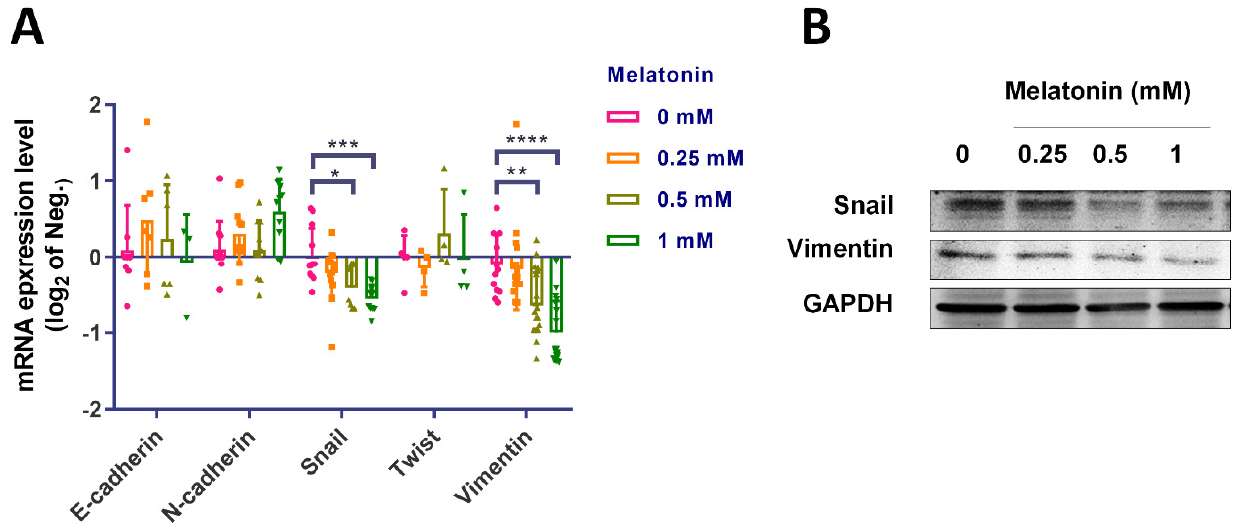
Figure 3. Melatonin inhibited EMT markers in bladder cancer cells. T24 bladder cancer cells, treated with various concentrations of melatonin (0–1 mM) for 24 h, were subjected to analysis of EMT marker expression. The expression levels of E-cadherin, N-cadherin, vimentin, snail and twist were examined by qPCR ( A ) and Western blot ( B ) analysis. GAPDH was used as the internal control. Results are expressed as the mean ± SEM. * p < 0.05, ** p < 0.01, *** p < 0.001, and **** p < 0.0001 compared with the control group.